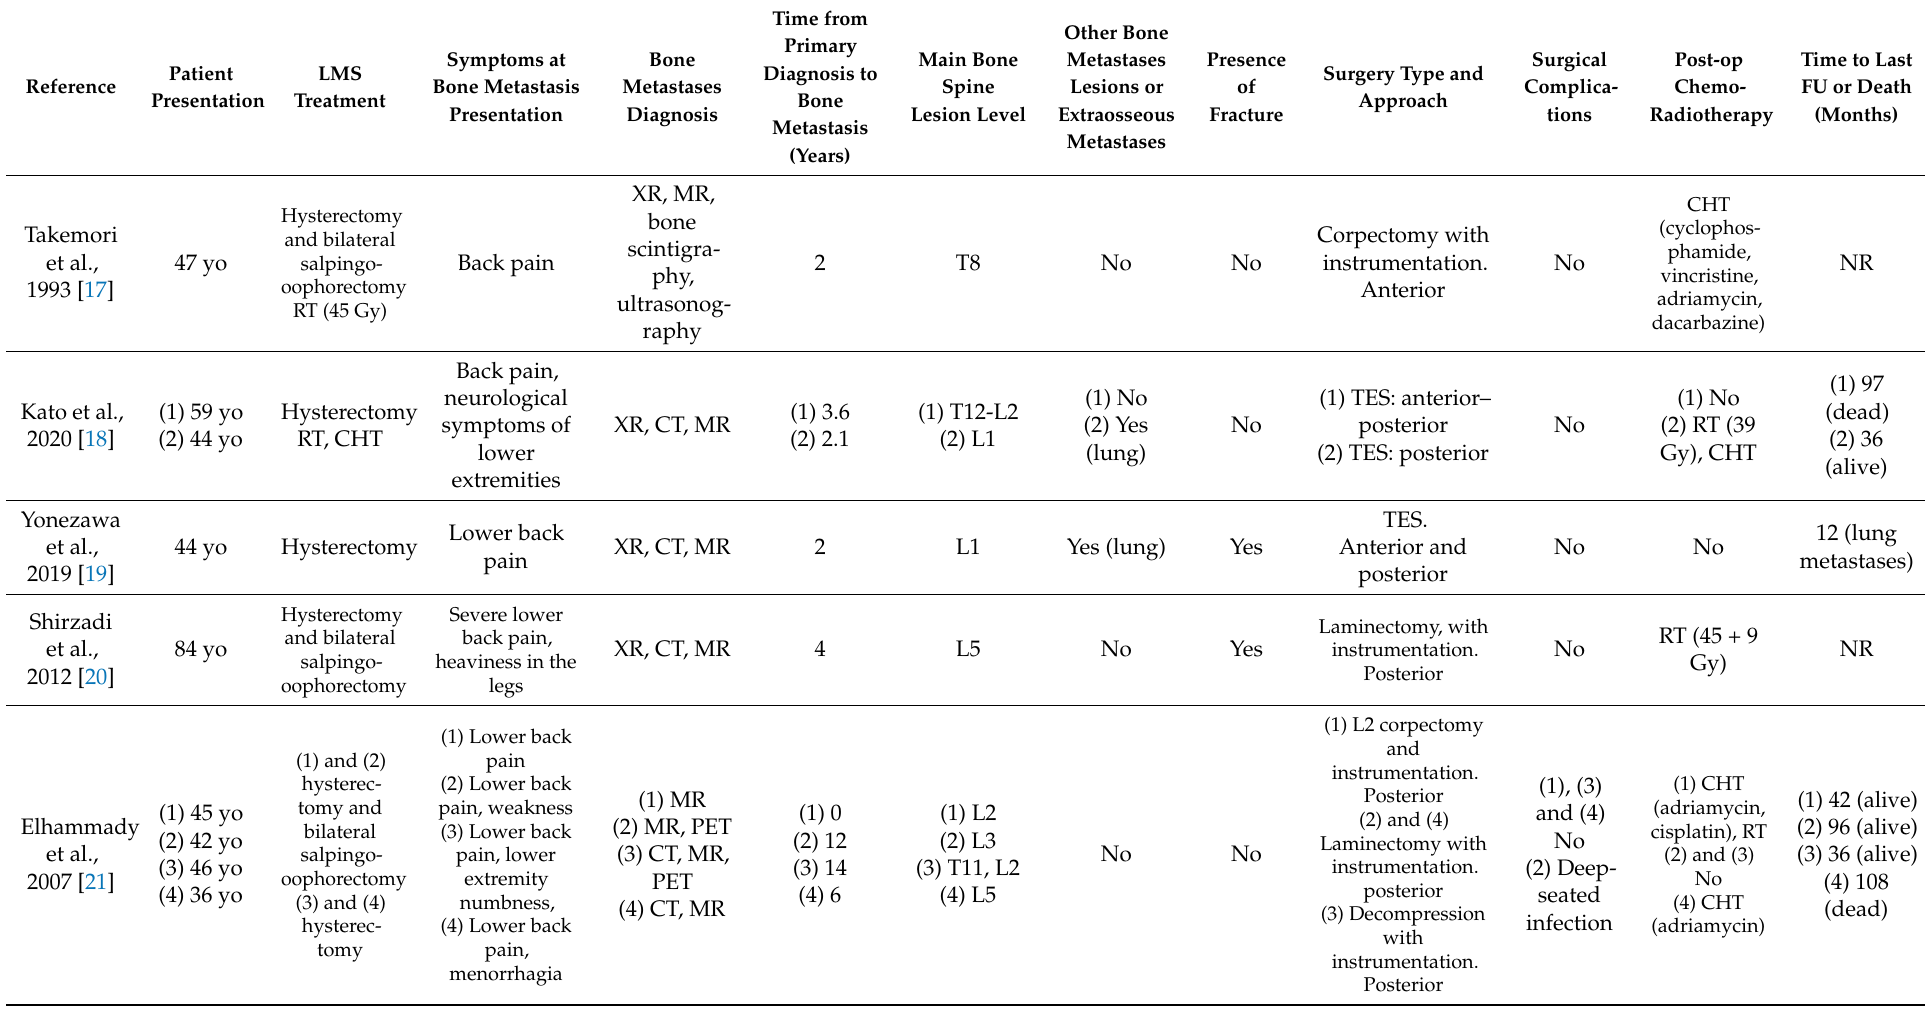
Table 6. General and clinicopathologic characteristics of previously published cases of bone metastasis from